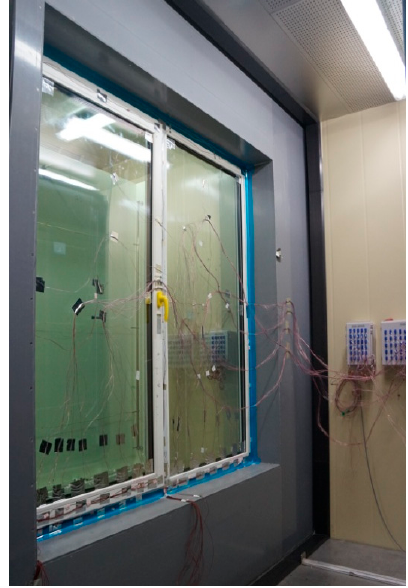
Figure 4. View of a test window in the hot box. Table 1. Boundary conditions for the test.